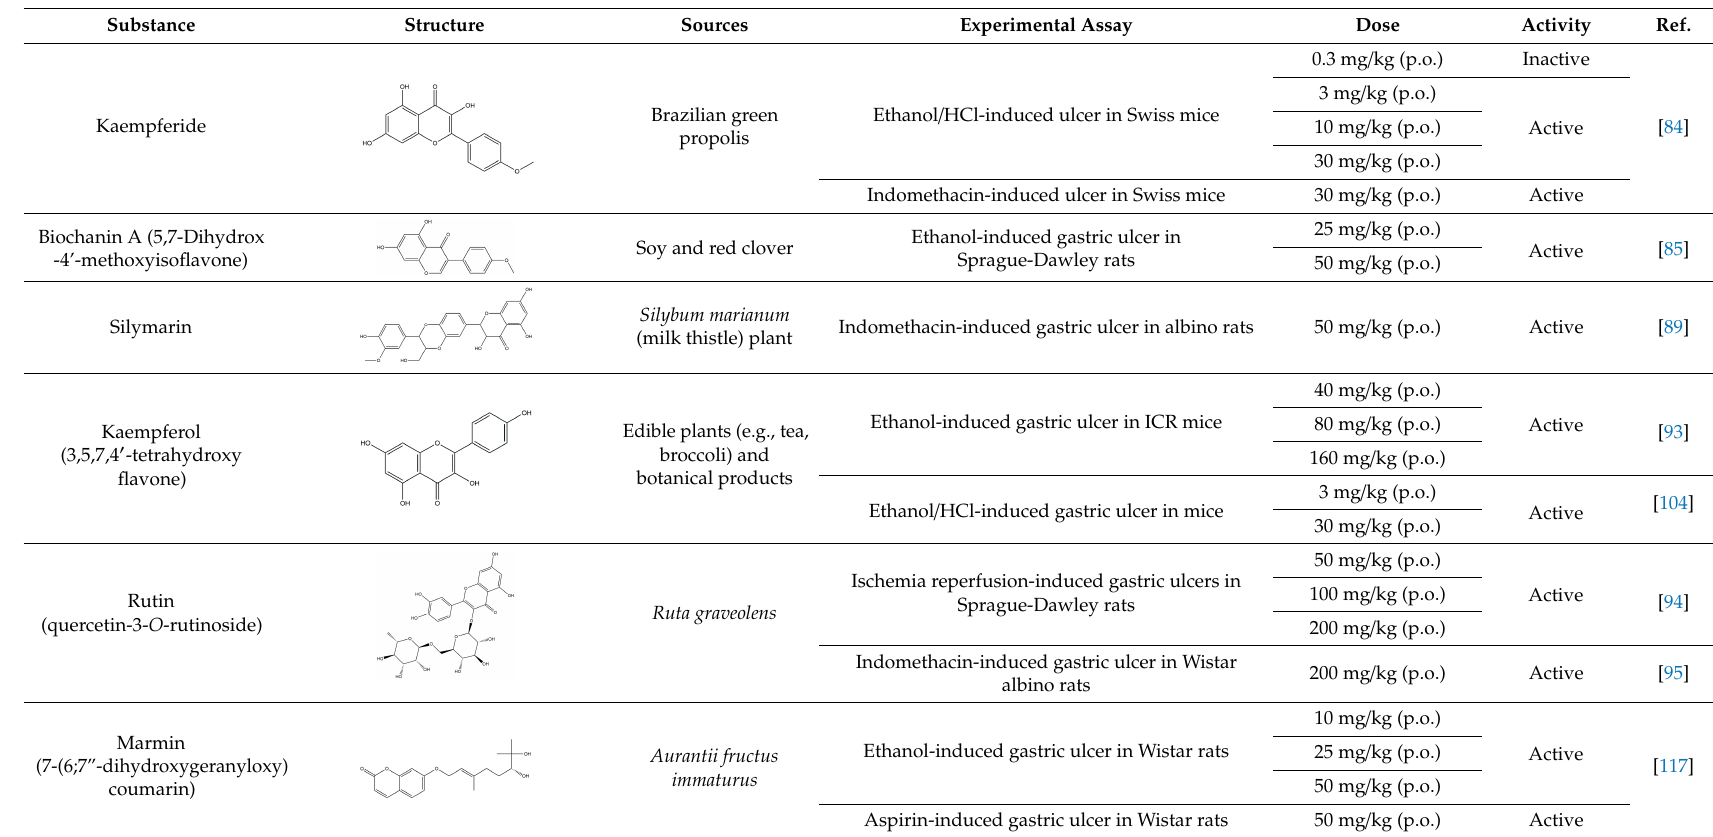
Table 2. Studies on the treatment of peptic ulcer with flavonoids.